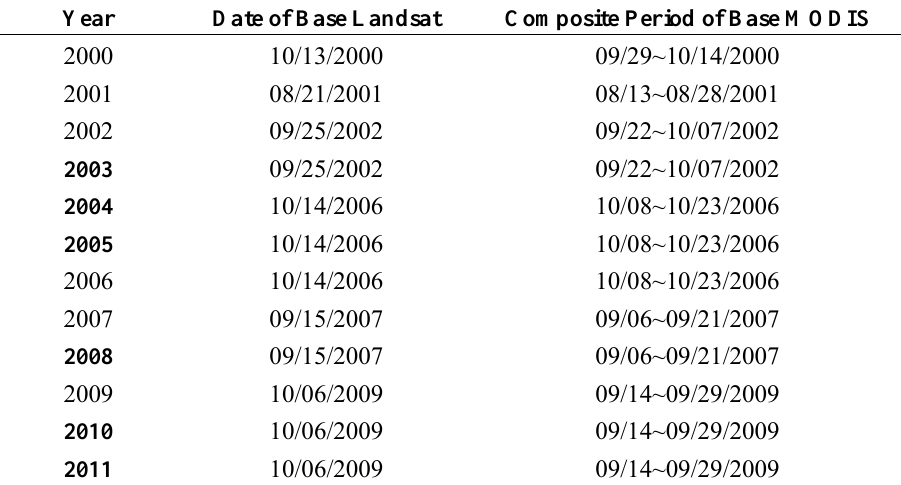
Table 1. Base pair images used in the generation of synthetic Landsat NDVI time series. MOD13Q1 products with a composite period closest to the observation time of Landsat images were selected as the base MODIS images. No available Landsat images were found in this study area for years highlighted (bold font), and base pair images from the adjacent year were used as inputs for